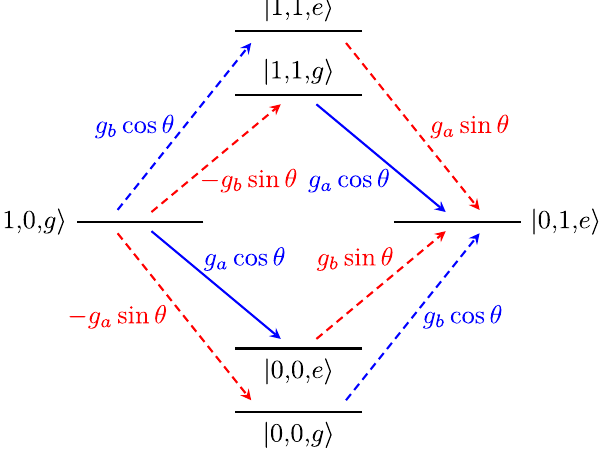
Figure 2. The four lowest-order processes contributing to a transition between |1, 0, g 〉 and |0, 1, e 〉 . For this illustration, the parameter values ω a = 3 ω q and ω b = 2 ω q were used to set the positions of the energy levels. The transitions that do not conserve excitation number are shown as dashed lines, and the excitation-number- conserving transitions are shown as solid lines. Red lines correspond to σ ˆ to σ ˆ (transverse) coupling in the Hamiltonian given in Eq. (1). Each transition is labelled by its matrix x